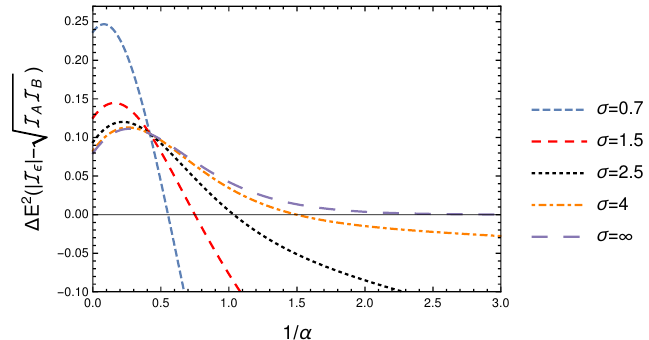
√ (cid:0) (cid:1) is plotted for two anti-parallelly |I ε | − I A I B = α A B